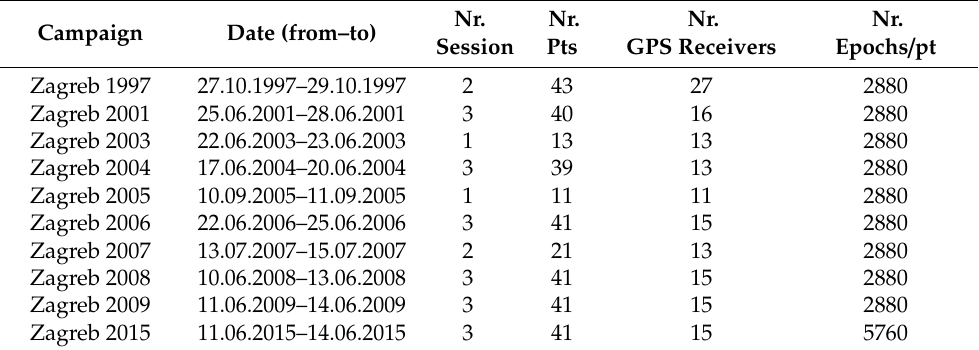
Table 1. All conducted GPS campaigns with the number of sessions, points included and used receivers. Campaign Date (from–to) Zagreb 1997 2 43 27 2880